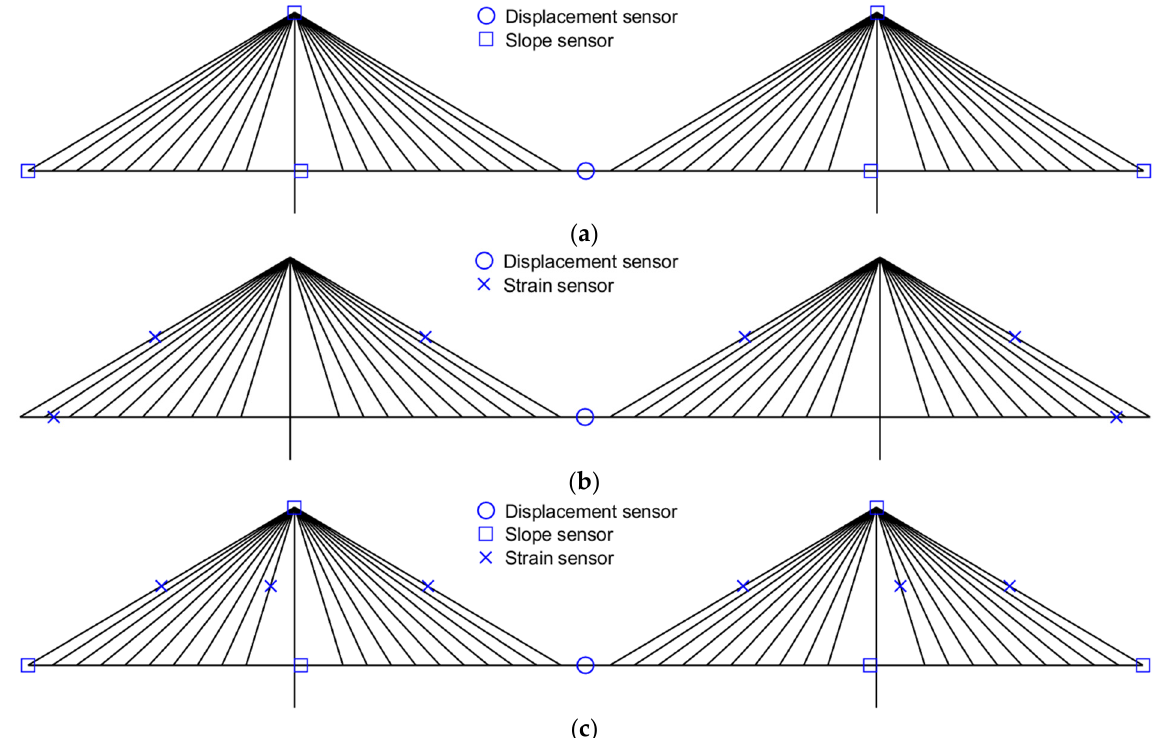
Figure 5. Example of measurement location using 1 displacement sensor. ( a ) ω = 1, ø = 6, ε = 0; ( b ) ω = 1, ø = 0, ε = 6; ( c ) ω = 1, ø = 6, ε = 6.